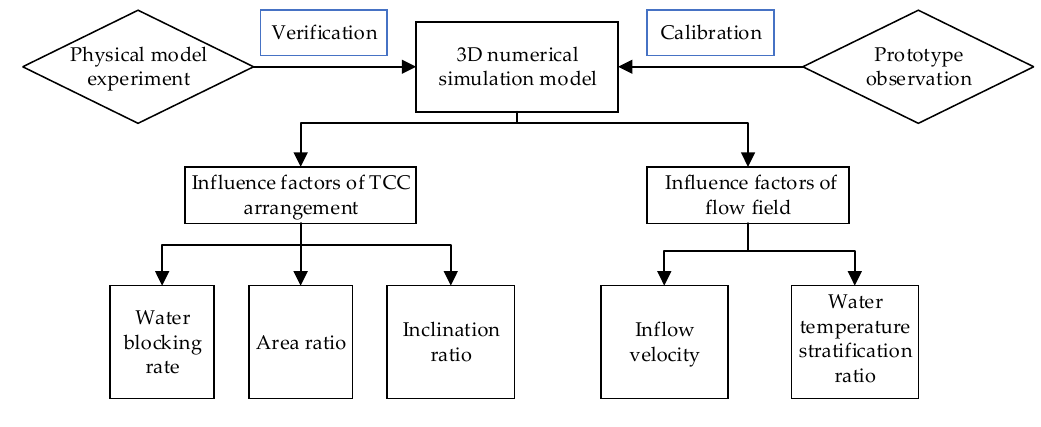
Figure 1. Working program.